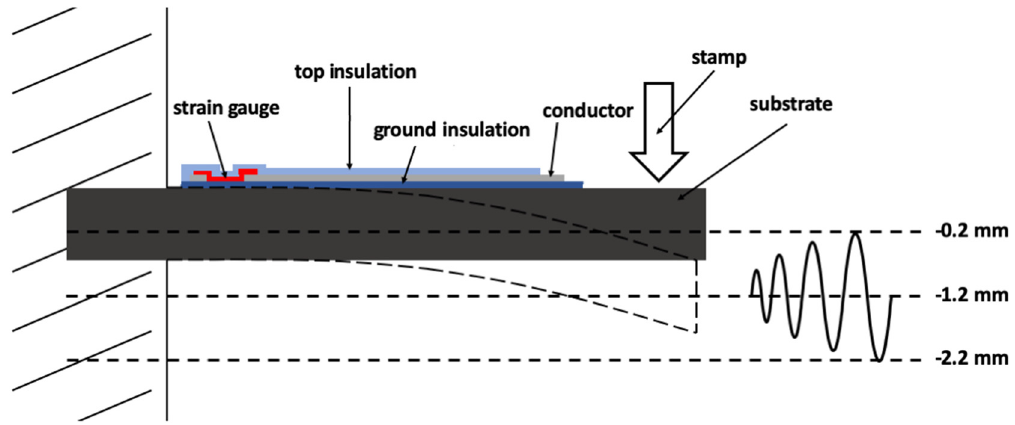
Figure 5. A schematic representation of the transverse beam test for sensor characterization prior to embedding.